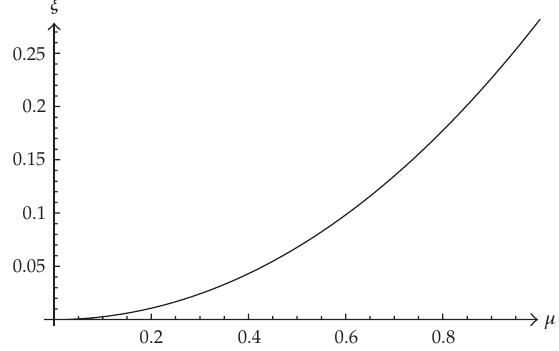
Figure 9: Sheared rod: tip’s abscissa as a function of the